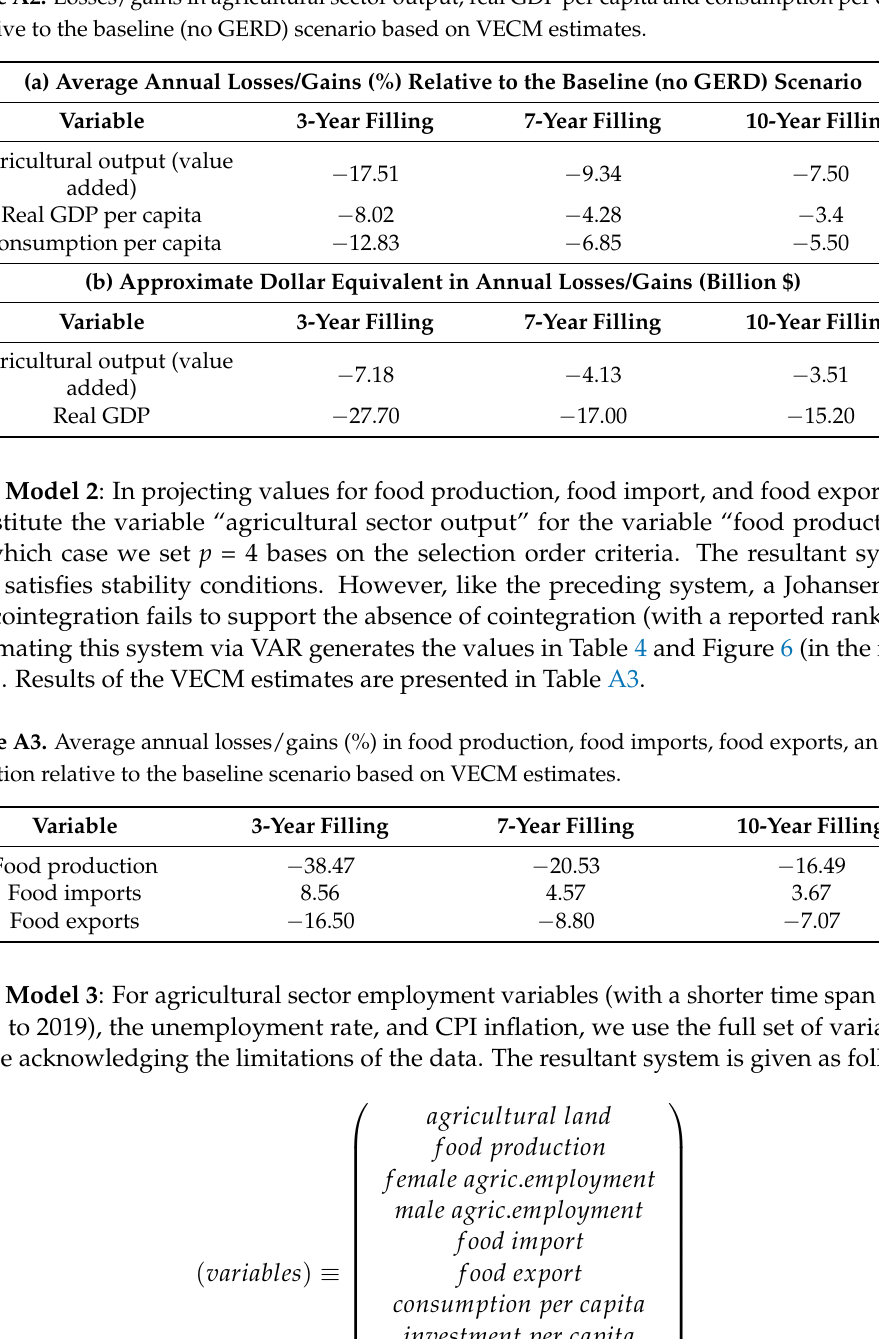
Table A2. Losses/gains in agricultural sector output, real GDP per capita and consumption per capita relative to the baseline (no GERD) scenario based on VECM estimates.